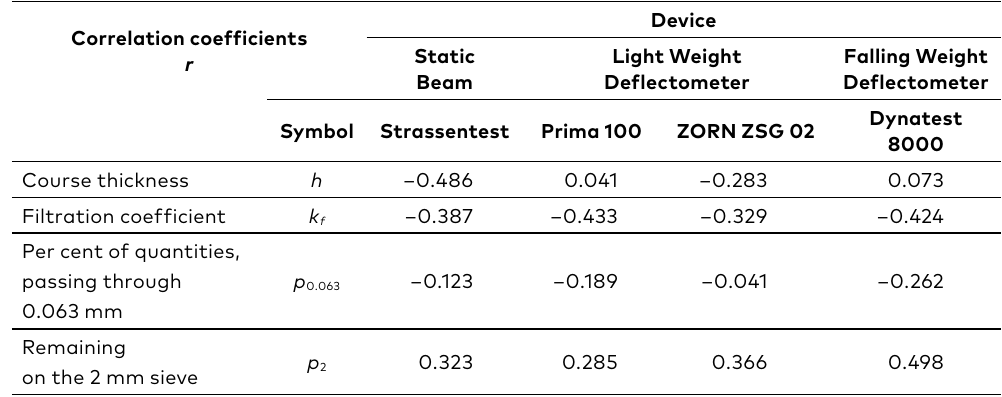
Table 3. The correlation coefficient of the deflection modulus